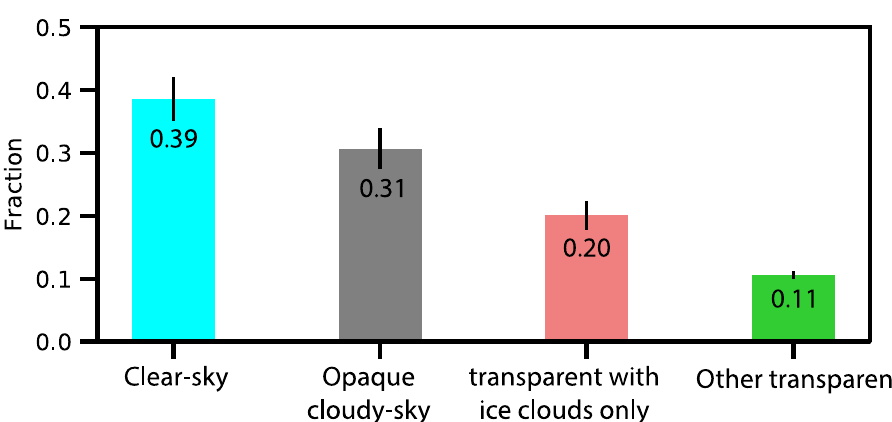
Figure 2. Clear-sky (cyan) and cloud occurrence fractions for the Raman lidar (RL) over at the Southern Great Plains (SGP) site from August 2008 to December 2014. The cloud occurrence fraction is partitioned into opaque cloudy-sky (gray) and transparent to the RL. The transparent fraction is further partitioned into transparent with ice clouds only (pink) and other transparent (green). The fraction values are labeled within each bar. The error bars are the corresponding one standard deviation of annual-mean fraction values from January 2009 to December